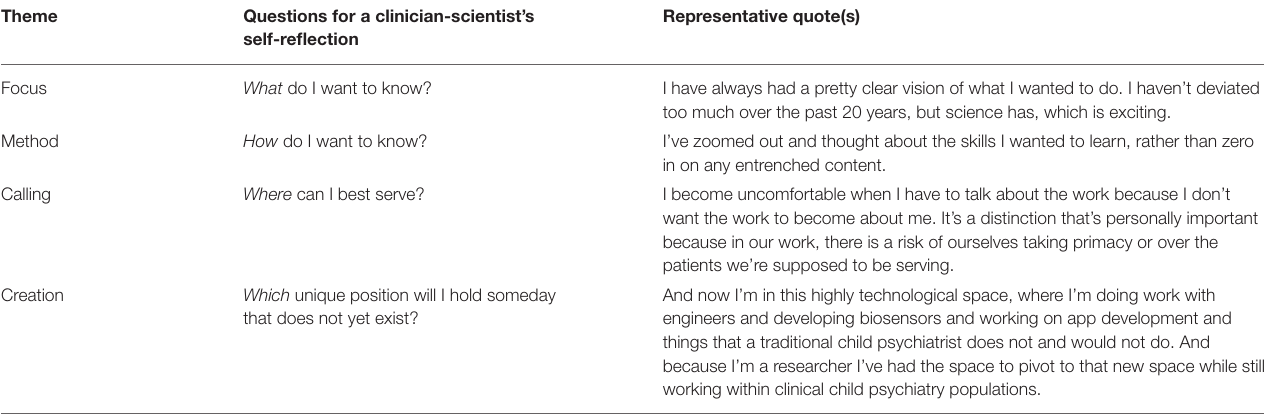
Table’s title and themes are adapted from